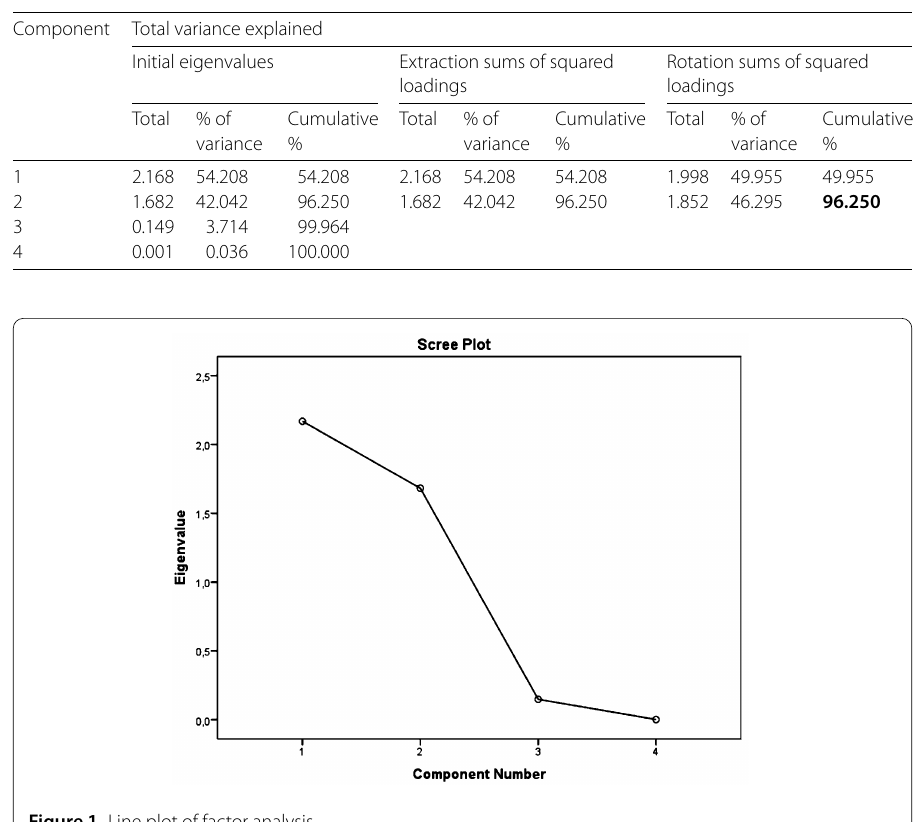
Figure 1 Line plot of factor